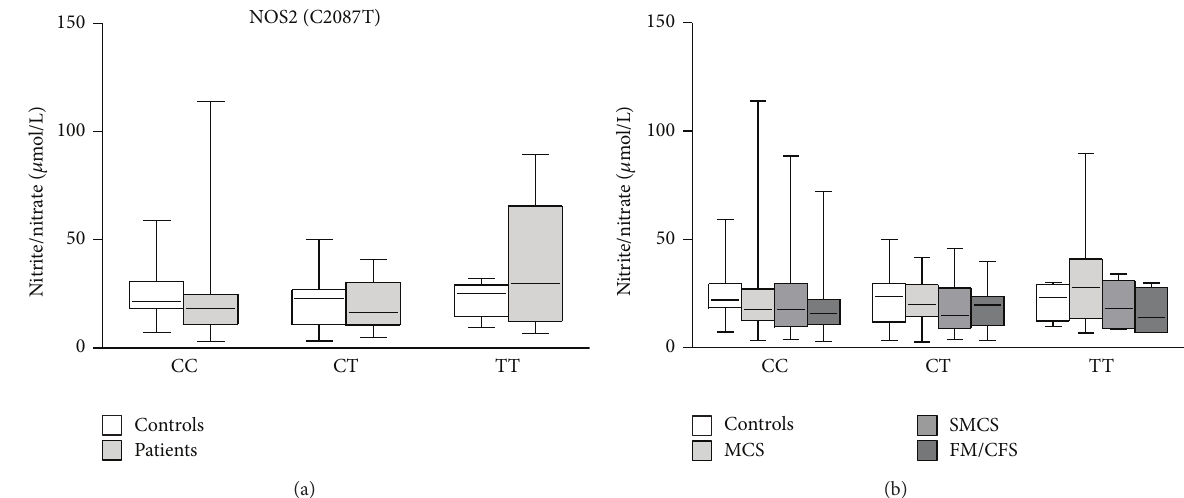
Figure 1: Effects of different NOS2A C2087T (Ser608Leu) genotypes on nitrite/nitrate plasma levels in IEI patients (MCS = 170; SMCS = 108; FM/CFS = 89), grouped together (a) or separated (b), and controls ( 𝑁 = 196 ). Box-plots graphically depict the variation in plasma nitrite/nitrate concentrations of patients and healthy subjects, having different NOS2A C2087T genotypes, through their quartiles. The bottom and top of the boxes are the first and third quartiles, and the band inside the boxes is the second quartile (the median); lines extending vertically from the boxes ( whiskers ) indicate variability outside the upper and lower quartiles (the ends of the whiskers represent the minimum and maximum of all of the data). MCS, multiple chemical sensitivity; SMCS, suspected multiple chemical sensitivity; FM/CFS, fibromyalgia/chronic fatigue syndrome; controls, healthy